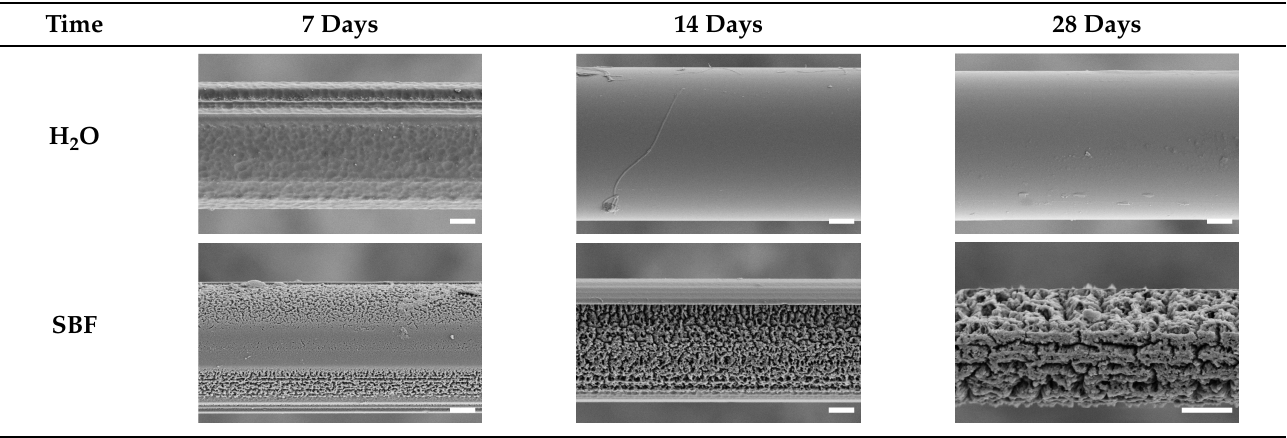
Table 8. SEM images of the dissolution of the fibres of the glass 18-06 (scale bars 2µm).